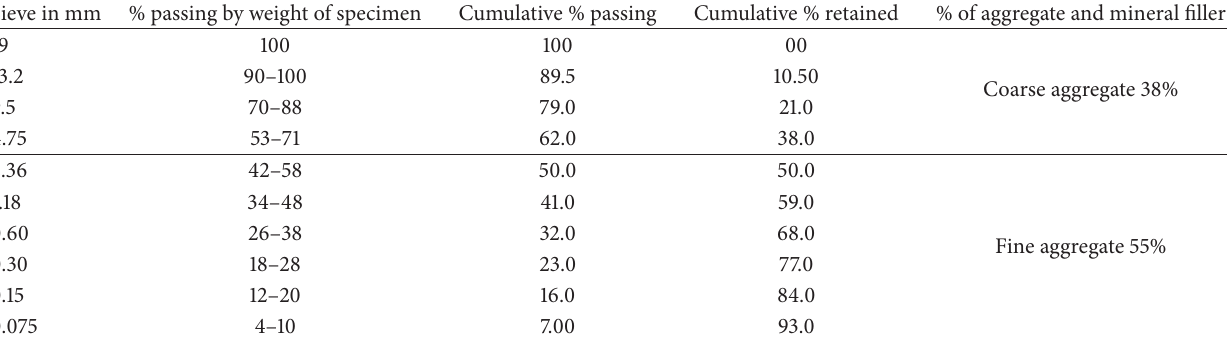
Table 5: Gradation of aggregate for bituminous concrete.